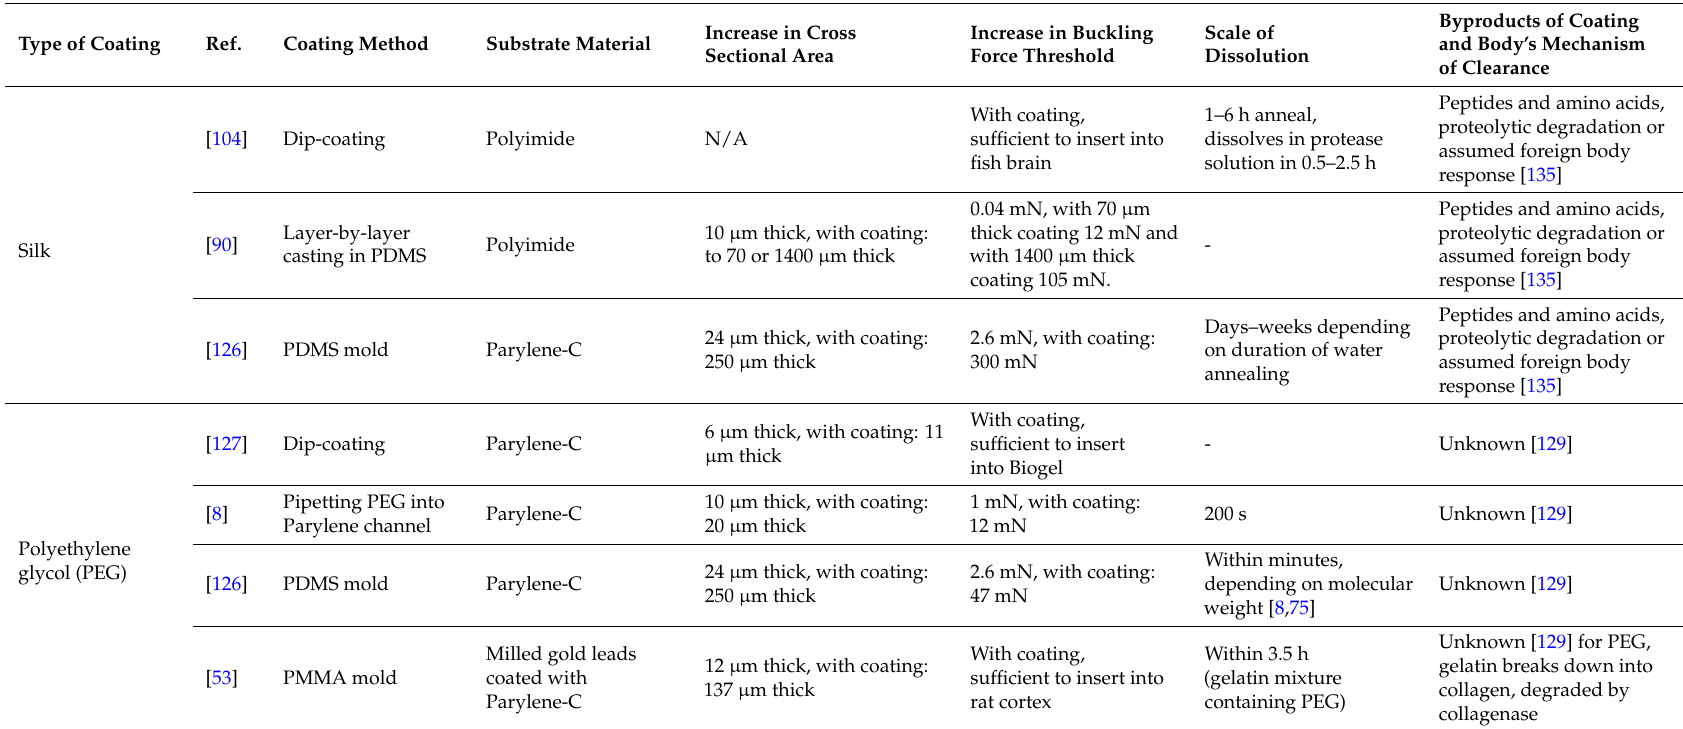
Table 3. Coatings used for flexible probes in